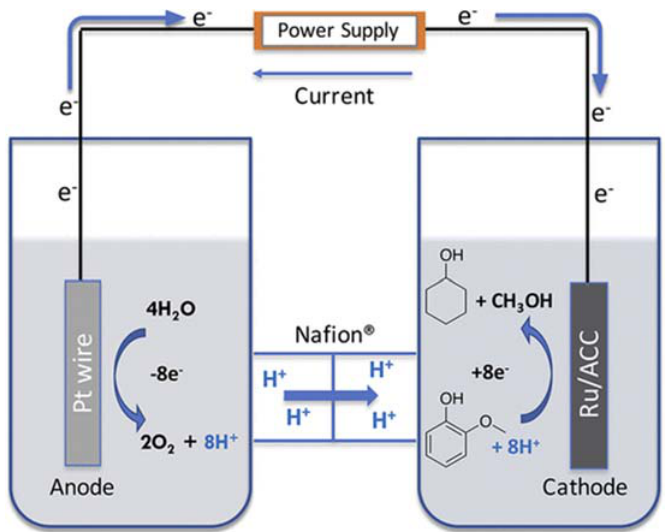
Figure 4. Schematic illustration of divided cell separated by Nafion-117 membrane. Reprinted with permissions from Ref. [96]. Copyright (2019) American Chemical Society.